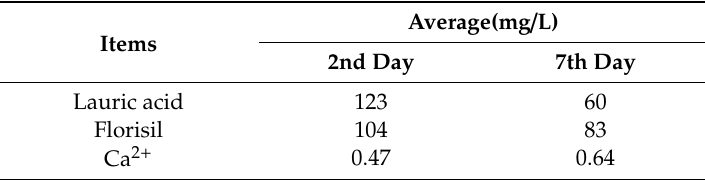
Table 4. Average of water quality